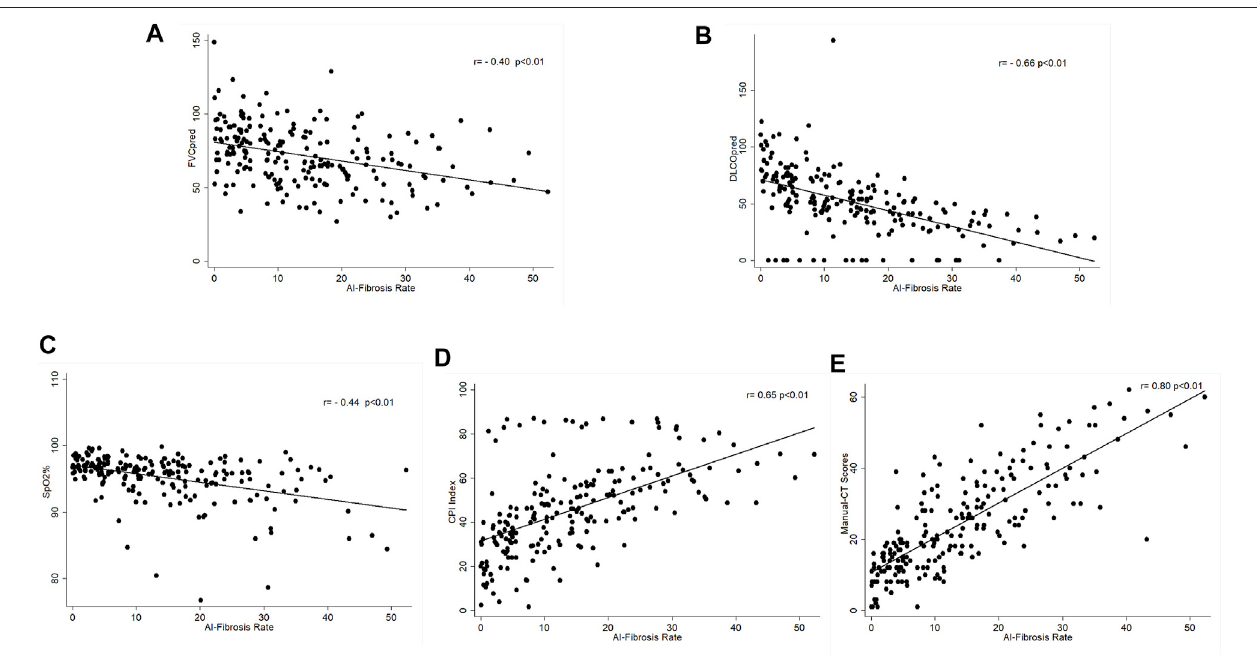
FIGURE 2 | Correlation of AI – CT fi brosis score and lung function parameters. (A) Correlation between CT-score and FVC%pred, Spearman correlation coef fi cient rs = -0.40, p < 0.01; (B) correlation between CT-score and DLco%pred, Spearman correlation coef fi cient rs = -0.66, p < 0.01; (C) correlation between CT-score and SpO2%, Spearman correlation coef fi cient rs = -0.44, p < 0.01; (D) correlation between CT-score and CPI, Spearman correlation coef fi cient rs = 0.65, p < 0.01; and (E) correlation between CT-score and manual-CT scores by radiologists, Spearman correlation coef fi cient rs = 0.80, p < 0.01.